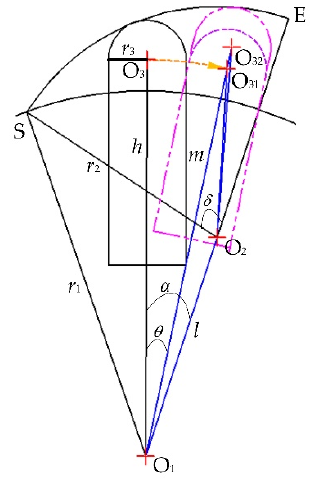
Figure 8. The relative position between the locking tab and the locking ring in ( a ) the locking state, ( b ) the unlocking state. 3—Actuator working cavity, 6—Locking tab, 7—Locking ring.